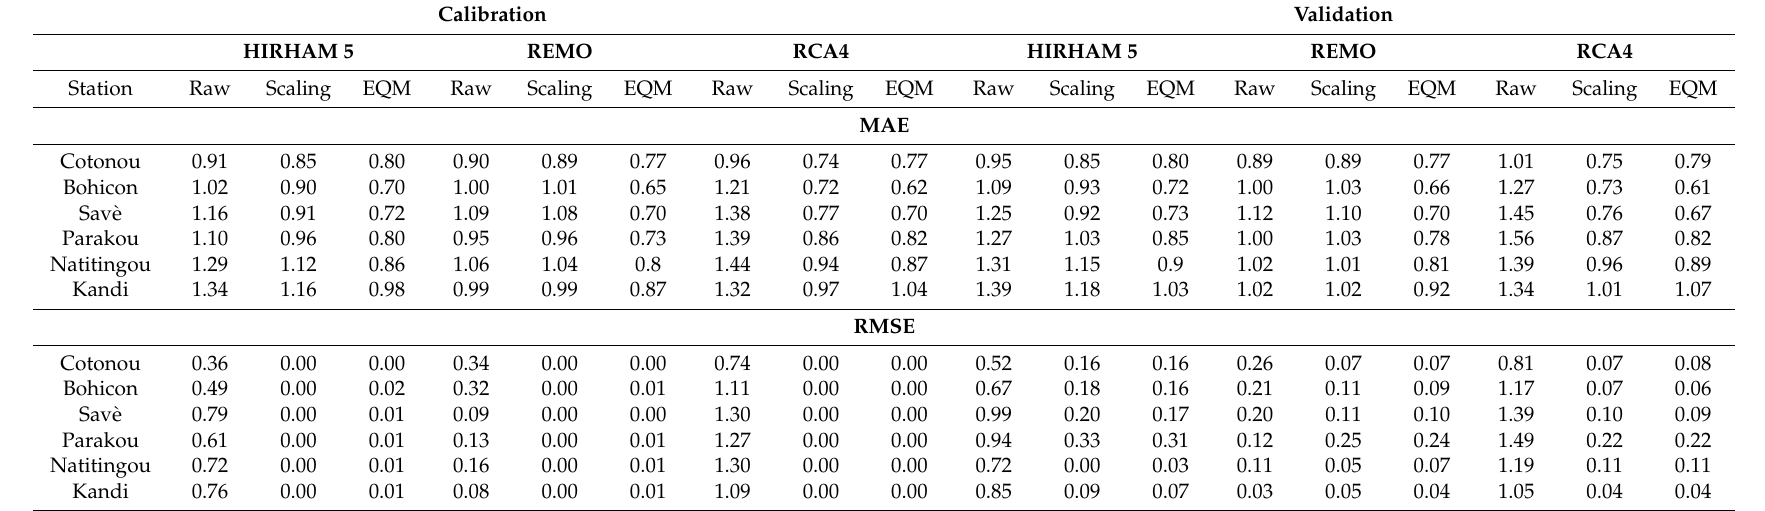
Table 4. Bias correction